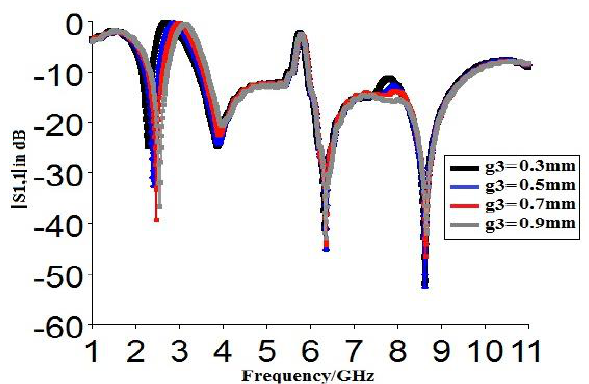
Figure 10: Simulated reflection coefficient for different R 2